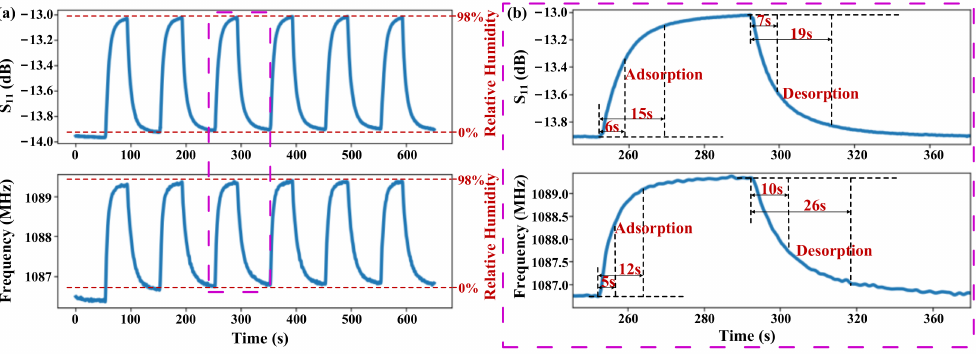
Figure 9. ( a ) Real-time response and ( b ) Humidity response time and recovery time performance of the resonant frequency and S 11 with periodic changes in humidity from 0% to 98% and 98% to 0%.